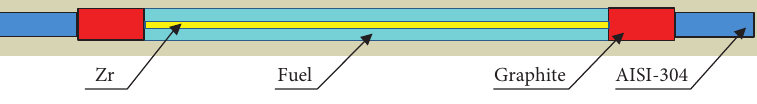
Figure 2: The detailed structure of the fuel